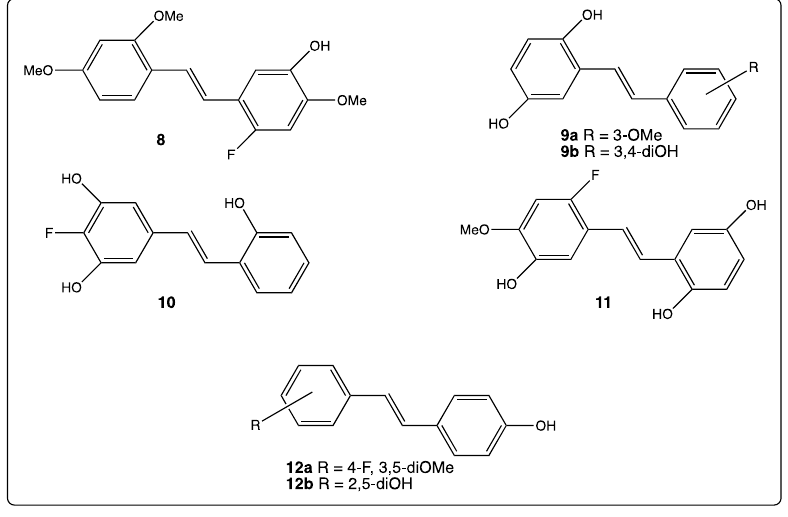
Figure 6 . Structure of compounds 8 – 12.